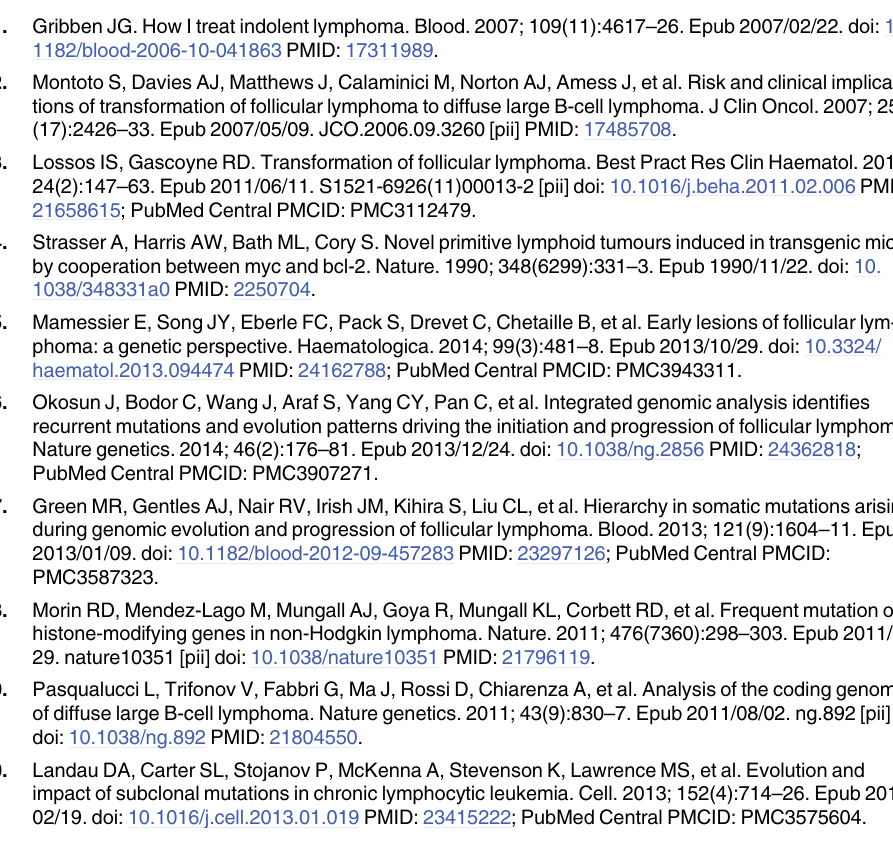
S2 Table. List of samples and sequence of the primers used for the high-throughput sequencing. S3 Table. Number and % of clones detected in the NS and sorted populations. S4 Table. Characteristics of the PGC and ME sub-populations. S5 Table. Prevalence of the haplotypes shared among the Pt1 samples and Pt2